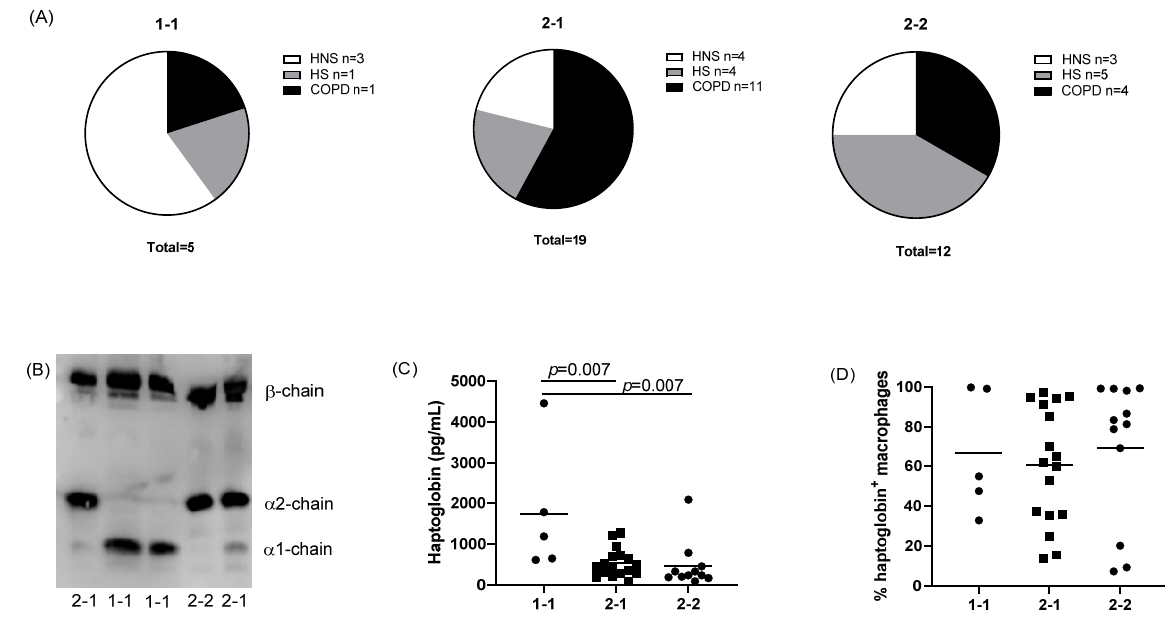
Figure 4. Haptoglobin genotype in the study population. The numbers of individuals with genotype 2-1 or 2-2 are presented ( A ) with a representative blot indicating genotype identification in serum samples ( B ). The levels of haptoglobin in sputum supernatants ( C ) and haptoglobin+ sputum macrophages ( D ) were compared between the different genotype groups. Data are presented as individual values with mean.